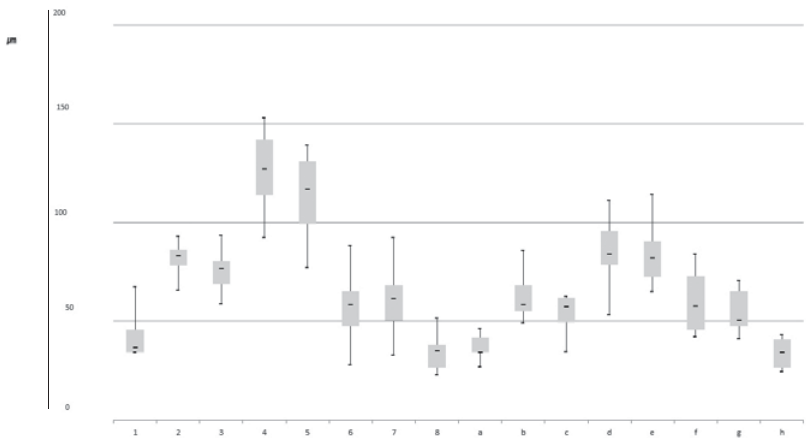
Figure 6- (cid:3)(cid:36)(cid:70)(cid:70)(cid:88)(cid:85)(cid:68)(cid:70)(cid:92)(cid:3)(cid:82)(cid:73)(cid:3)(cid:191)(cid:87)(cid:3)(cid:82)(cid:73)(cid:3)(cid:72)(cid:68)(cid:70)(cid:75)(cid:3)(cid:80)(cid:72)(cid:68)(cid:86)(cid:88)(cid:85)(cid:76)(cid:81)(cid:74)(cid:3)(cid:83)(cid:82)(cid:76)(cid:81)(cid:87)(cid:3)(cid:76)(cid:81)(cid:3)(cid:74)(cid:85)(cid:82)(cid:88)(cid:83)(cid:3)(cid:23)(cid:3)(cid:11)(cid:38)(cid:40)(cid:53)(cid:40)(cid:38)(cid:3)(cid:54)(cid:58)(cid:3)(cid:23)(cid:17)(cid:21)(cid:15)(cid:3)(cid:27)(cid:19)(cid:3) (cid:80) m). Uppermost point and lowermost point indicate the highest and lowest values of results. The top of box and bottom of box indicate the 75% and 25% values of results. The midline in the box means the average of the results